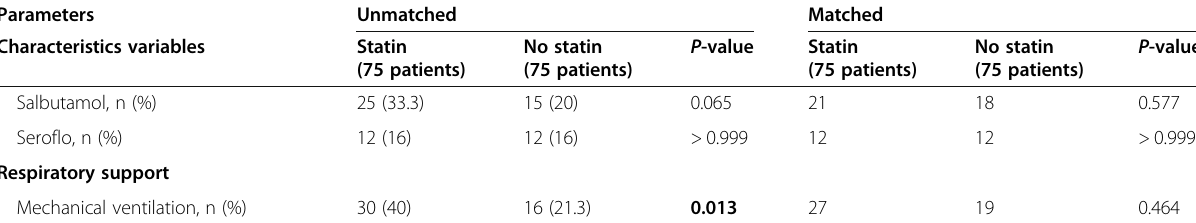
Table 1 Characteristics and comparison of patient groups (statin vs no statin), before and after propensity score matching (Continued) Parameters